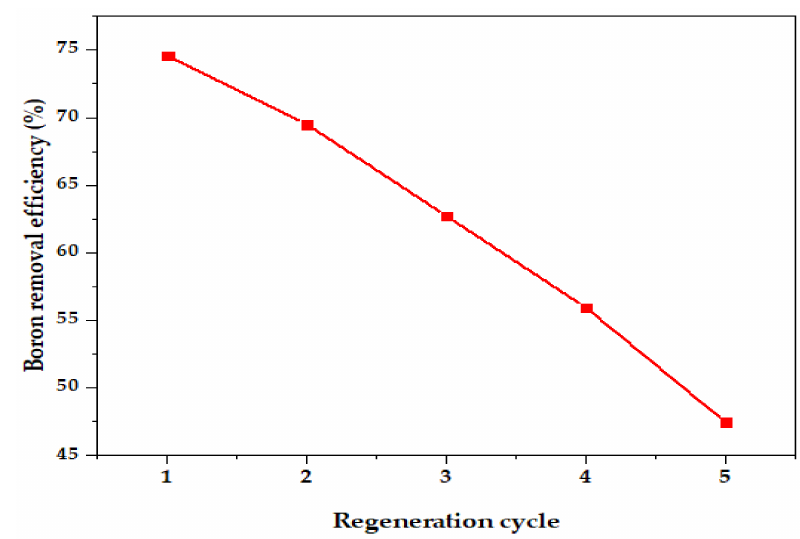
Figure 12. Reusability of nano-magnetite for boron adsorption.